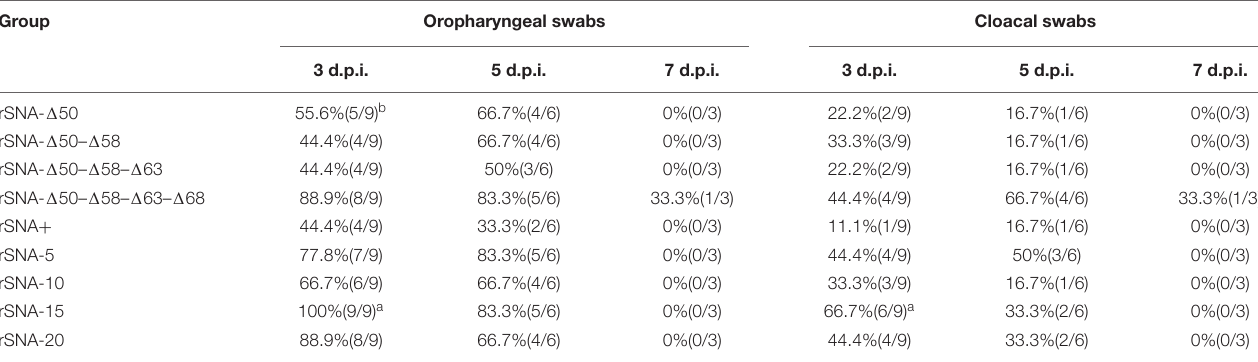
TABLE 5 | The viral positive ratio of oropharyngeal and cloacal swabs. Group Oropharyngeal swabs Cloacal